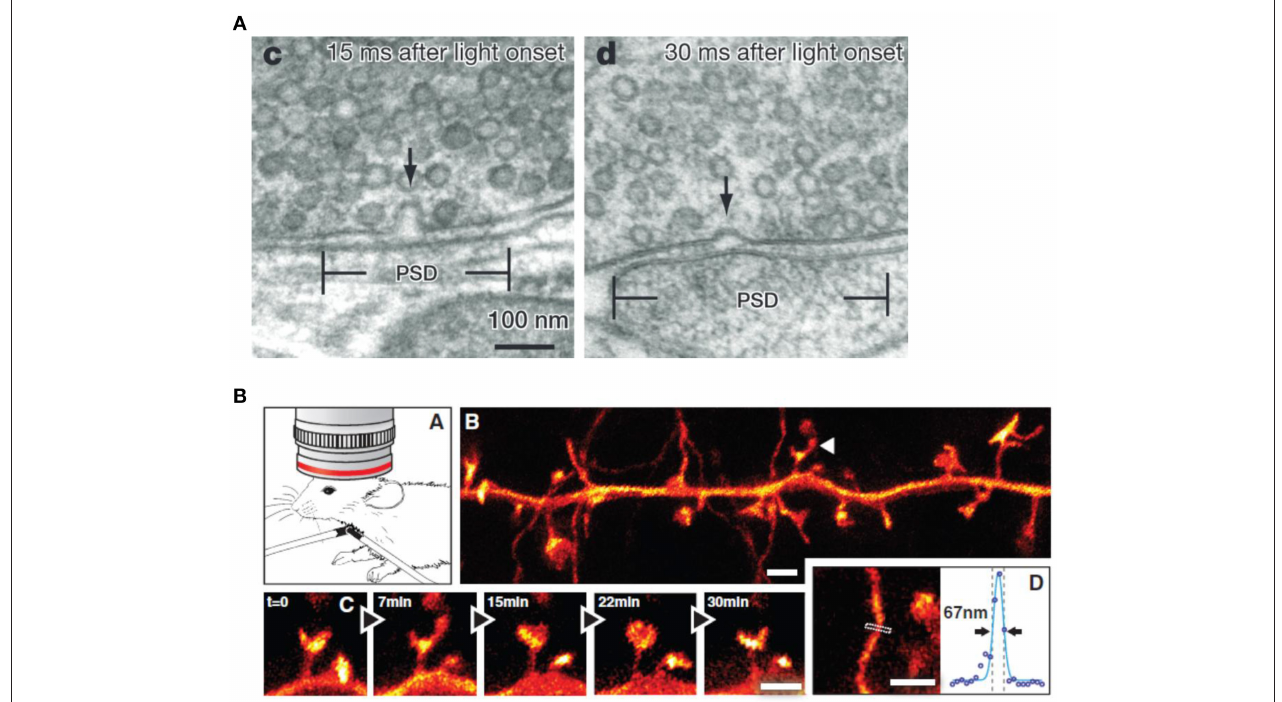
FIGURE 17 | (A) Representative cryo electron micrographs of fusing vesicles (see arrows) in mouse hippocampal synapses at 15ms (c) and 30ms (d) after light onset (Watanabe et al., 2013). Reprinted with permission from Watanabe et al. (2013) © 2013 Nature Publishing Group. (B) STED (stimulated emission depletion) microscopy in the molecular layer of the somatosensory cortex of a mouse with EYFP-labeled neurons. (A) Anesthetized mouse under the objective lens. (B) Projected volumes of dendritic and axonal structures reveal (C) temporal dynamics of spine morphology with (D) an approximately four-fold improved spatial resolution compared with diffraction limited imaging. The curve is three-pixel-wide line profile fitted to raw data with a Gaussian. Scale bars, 1 µ m (Berning et al., 2012). Reprinted with permission from Berning et al. (2012) © 2012 AAAS.